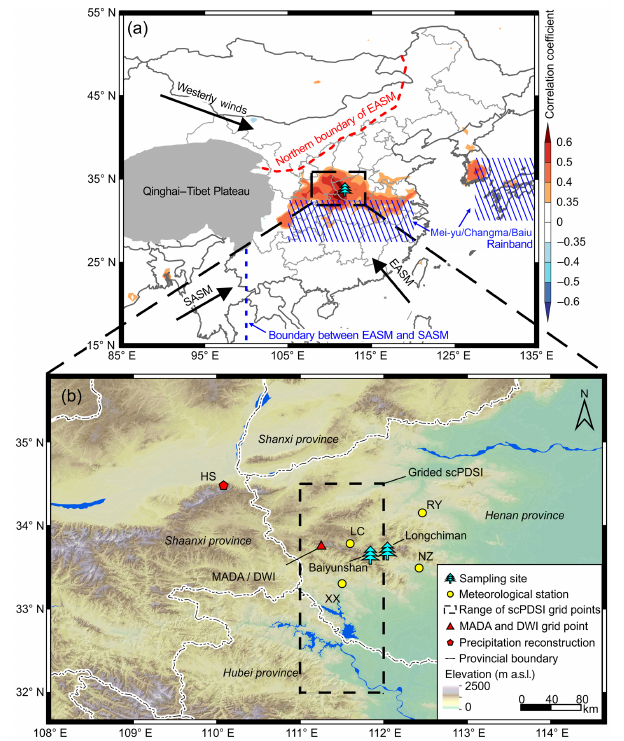
Figure 1. Map of the study region. (a) Location of the sampling site (tree symbol) and the spatial correlations between the May to July (MJJ) scPDSI reconstruction and the gridded scPDSI dataset (van der Schrier et al., 2013) during the period 1953–2005. The color bar indicates the correlation coefficient. The dashed blue line (100 ◦ E) indicates the boundary between East Asian summer mon- soon (EASM) and South Asian summer monsoon (SASM; Tang et al., 2010). The dashed red line indicates the northern boundary of EASM (Chen et al., 2018). The blue shaded area represents the Mei-yu/Changma/Baiu rainband (Zhao et al., 2015). (b) Partial en- largement of the study region. The circles indicate the locations of the four meteorological stations (LC: Luanchuan, XX: Xixia, RY: Ruyang, and NZ: Nanzhao). The triangle indicates the location of selected grid data from the datasets Monsoon Asia Drought At- las (MADA; Cook et al., 2010) and Dryness/Wetness Index (DWI; Yang et al., 2013). The pentagon indicates a precipitation recon- struction based on tree-ring width on Mount Hua (HS; Chen et al., 2016b). The dashed rectangle indicates the gridded scPDSI ob- tained from the gridded scPDSI dataset (van der Schrier et al., 2013).